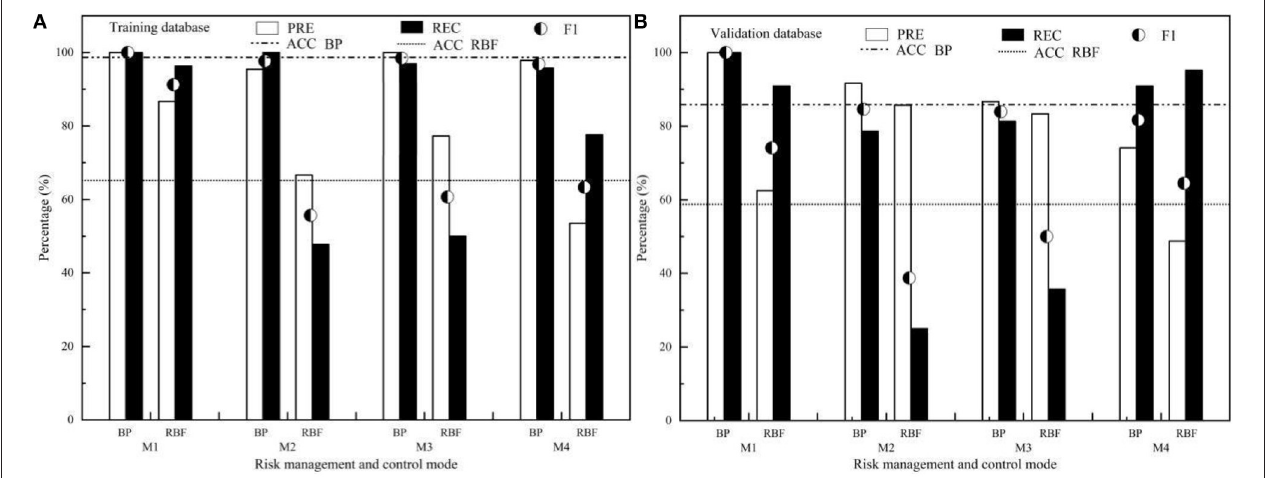
FIGURE 6 | The prediction performance evaluation for ANN of BP and RBF (A) Training database; (B) Validation database.